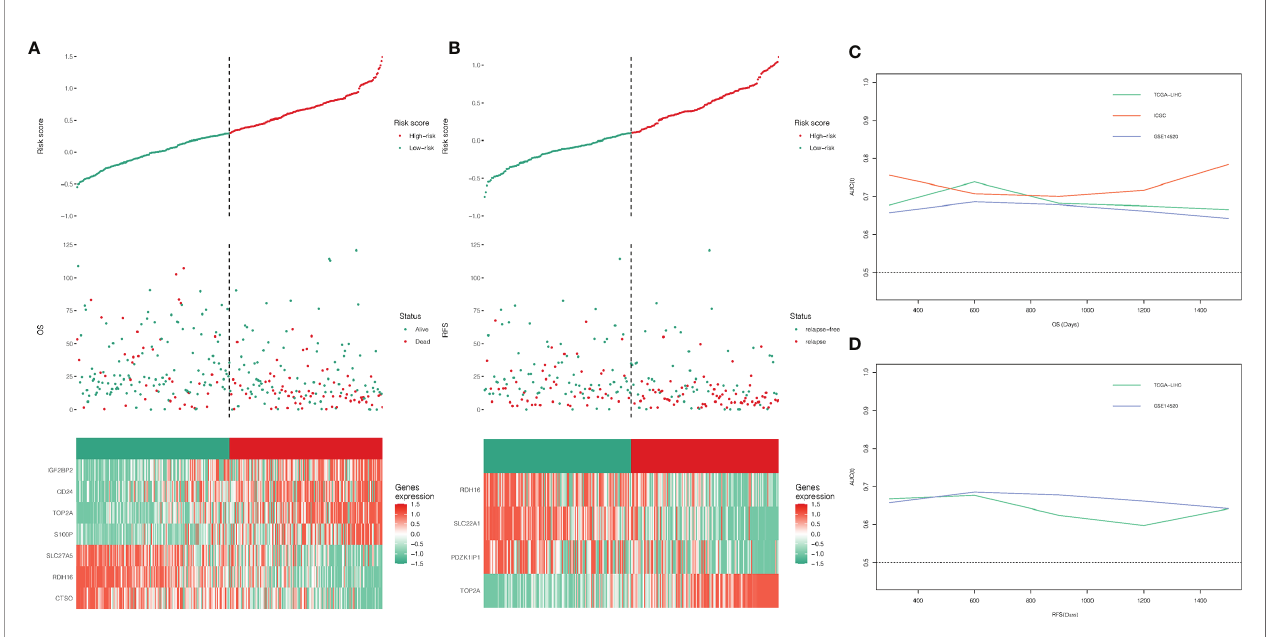
FIGURE 3 | (A, B) Analysis of NRS in OS and RFS, grouped by median; (C, D) time-dependent ROC